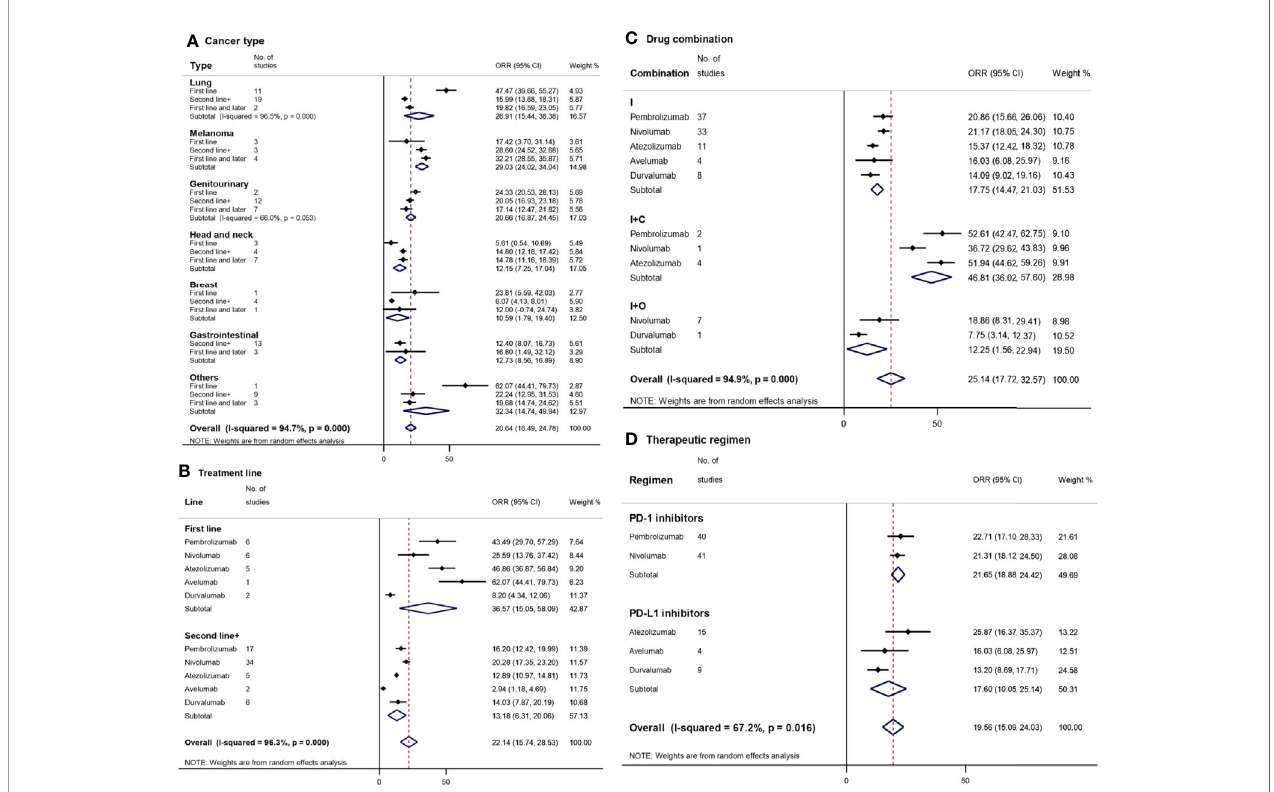
FIGURE 2 | Forest plot for objective response rate (ORR) by cancer type (A) , treatment line (B) , drug combination (C) , and therapeutic regimen (D) . Squares represent the study-speci fi c effect size (ORR). The area of the square is inversely proportional to the standard error of the study (and therefore indirectly to the sample size), and a larger area indicates greater weight in the calculation of the pooled effect size. The horizontal line crossing the square represents the 95% CI. The diamonds represent the estimated overall effect based on the meta-analysis. CI, con fi dence